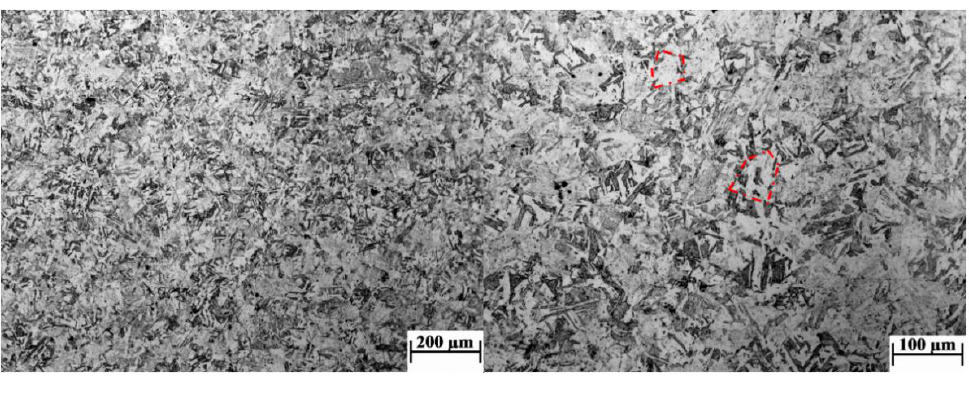
Figure 6. Grain size of single heating process.